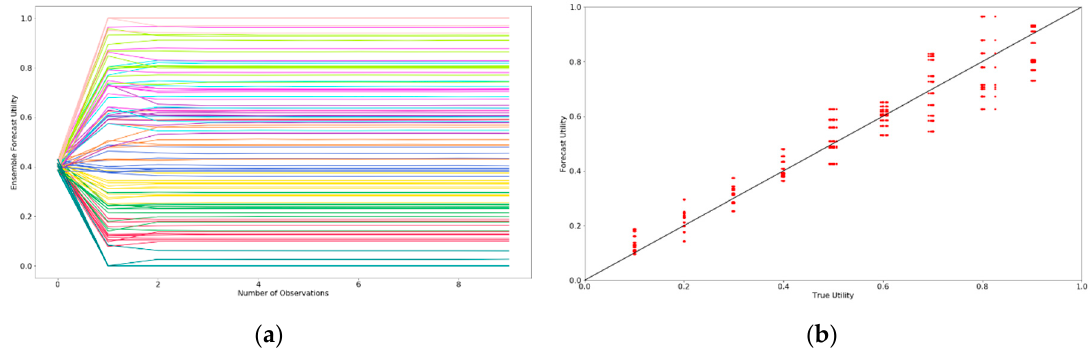
Figure 8. ( a ) Evolution of the average ensemble forecast utility as a function of the number of observations. Colors group analyses by the selected utility of the truth model. ( b ) comparison of the average utility constrained with 3 observations to that of the truth model for all realizations.